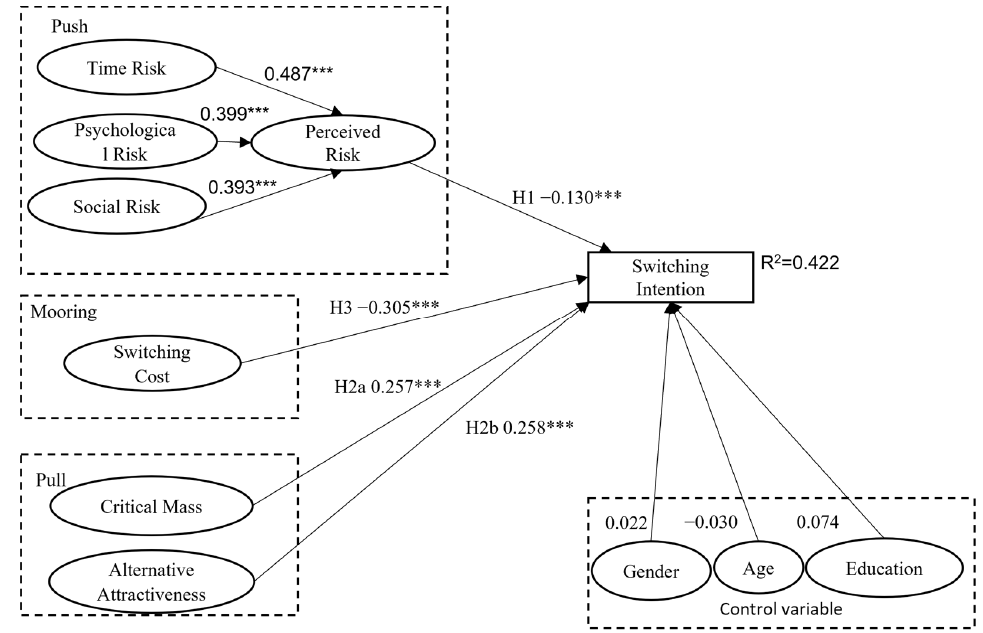
Figure 3. PLS results of the research model. *** p < 0.05.